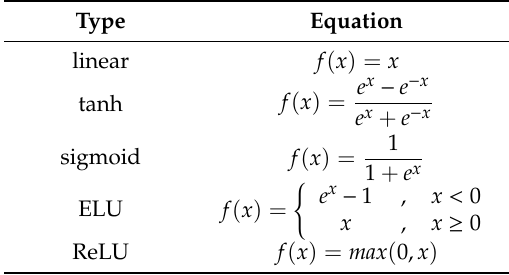
Table 5. The mathematical expression of five commonly activation functions.